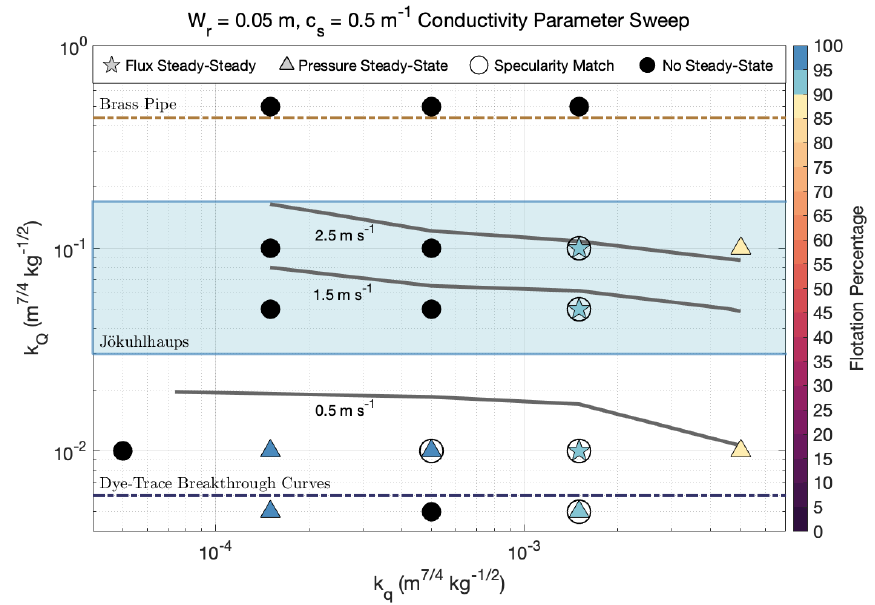
Figure A3. Same as Fig. 4 but for bed roughness parameters W r = 0 . 05m and c s = 0 . 5m − 1 .